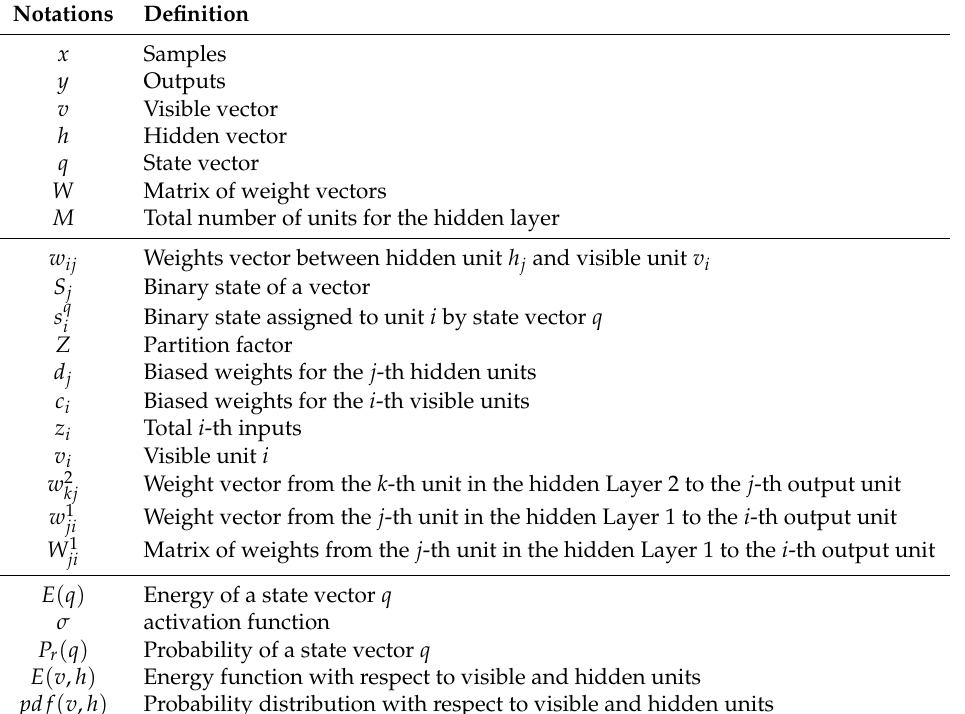
Table 1. Basic notations used in the article. Notations are grouped into three categories: stand-alone symbols, vectors between units of different layers and symbols for